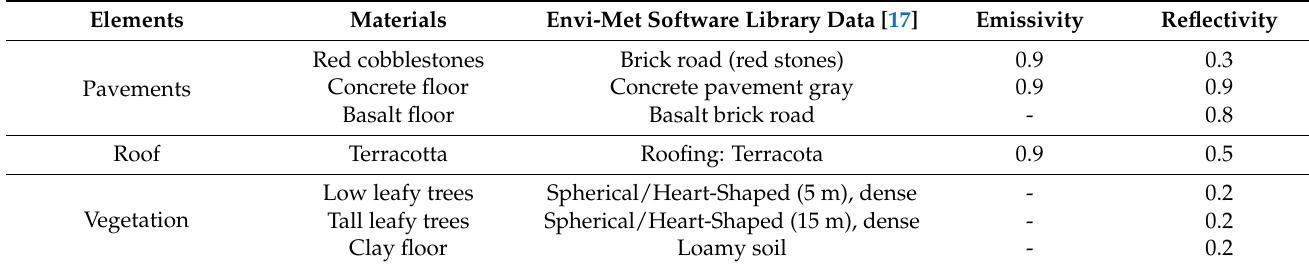
Table 1. Materials for the current case/cutout base.